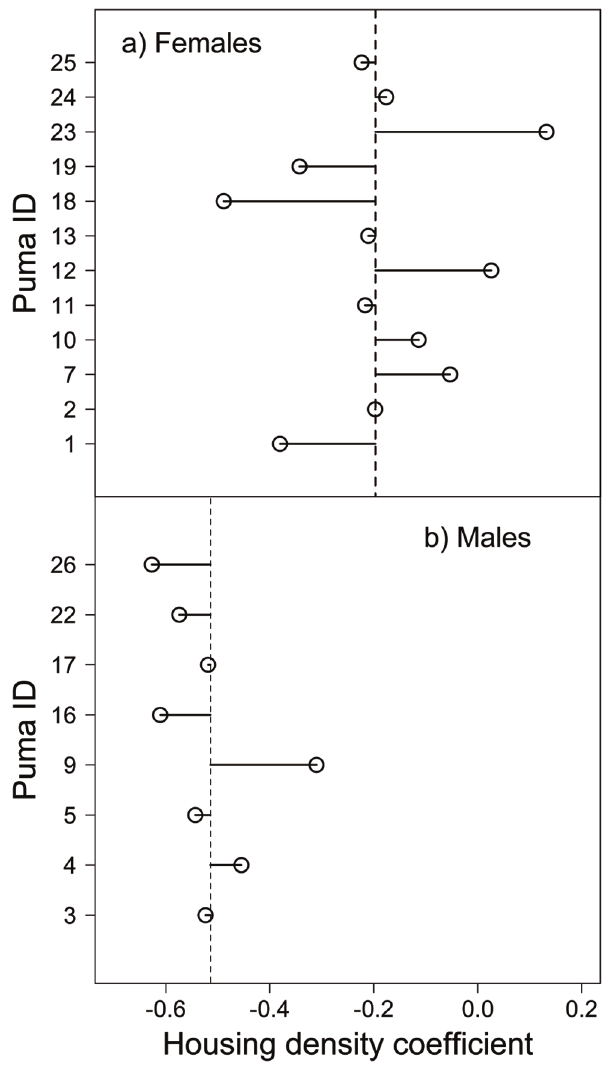
Figure 3. Estimates of the random effect coefficient of housing density for each puma are plotted in relation to the marginal prediction (dashed line) for a) females and b) males. Females were more tolerant of human development and displayed greater variation in their response than males, likely due to life history differences related to breeding and raising young. The sole dispersing male (M9) in our sample exhibited a tolerance of housing density more similar to that of females than other